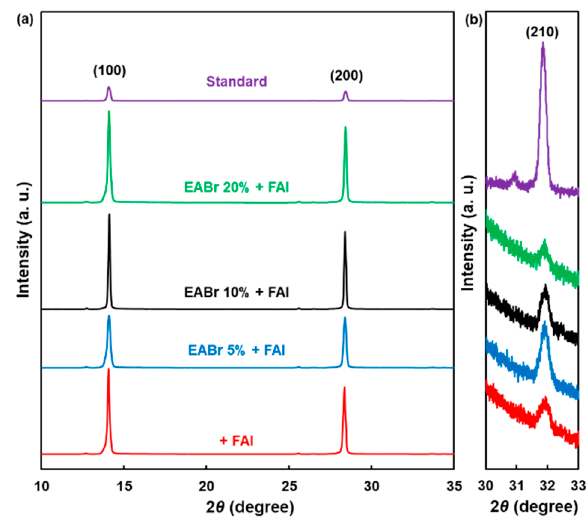
Figure 7. ( a ) X-ray diffraction (XRD) pattern of the present solar cells and ( b ) enlarged pattern of ( a